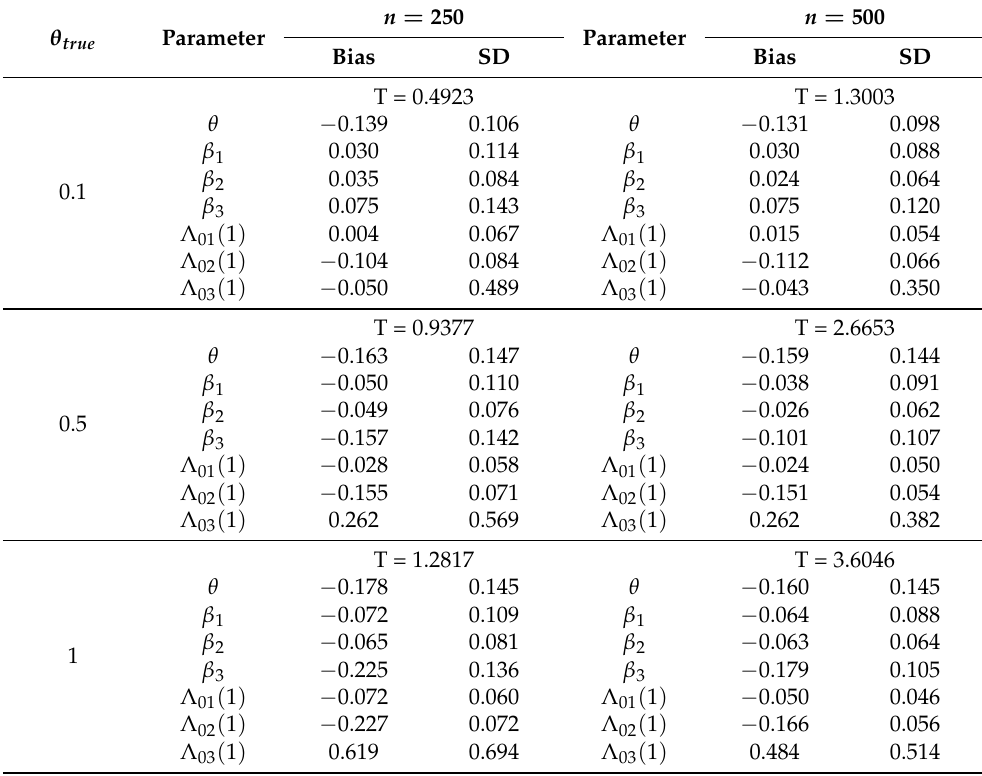
Table 3. The simulation results of the illness–death model with log-normal